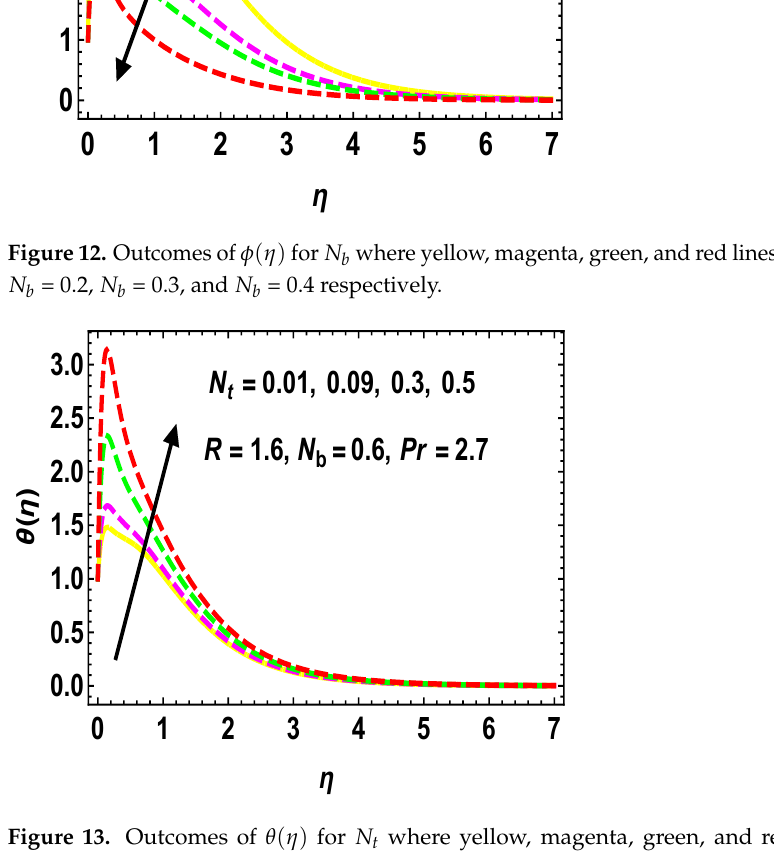
Figure 13. Outcomes of θ ( η ) for N t where yellow, magenta, green, and red lines represent for N t = 0.01, N t = 0.09, N t = 0.3, and N t = 0.5